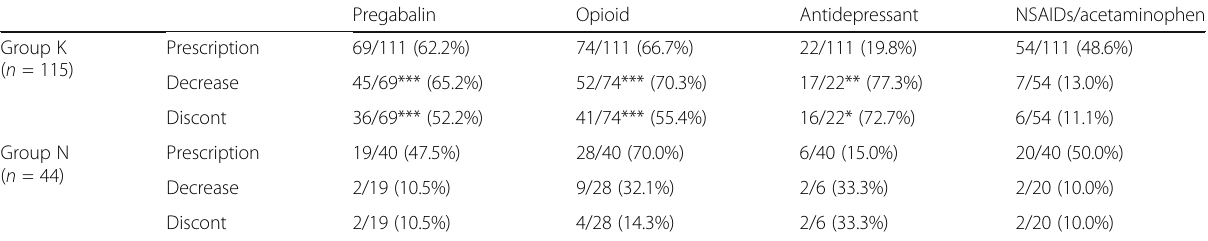
Table 3 The number of patients who were prescribed each drug and were followed-up